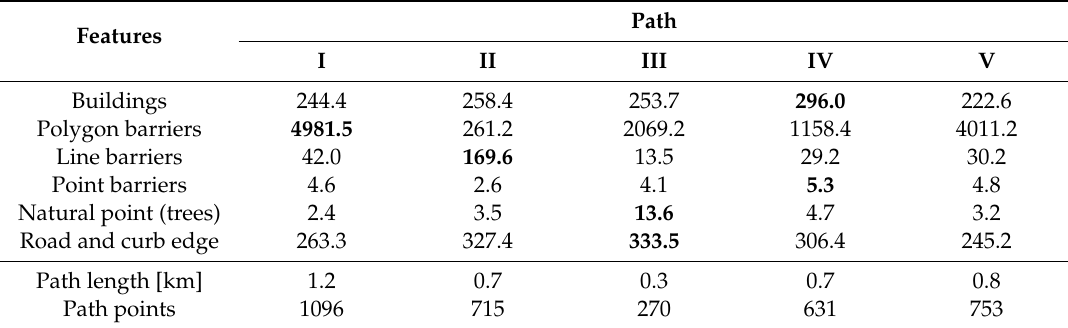
Table 7. Mean number of intersection points with features per path point, split by path. The highest value for each feature is highlighted in